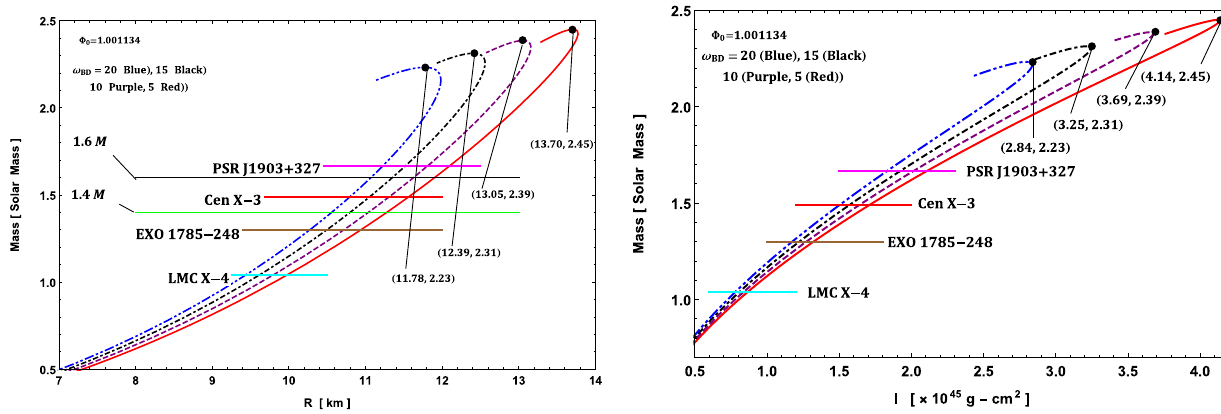
Fig. 8 The M − R and M − I curves are plotted by taking the same values as in Fig. 1 for different values of ω BD